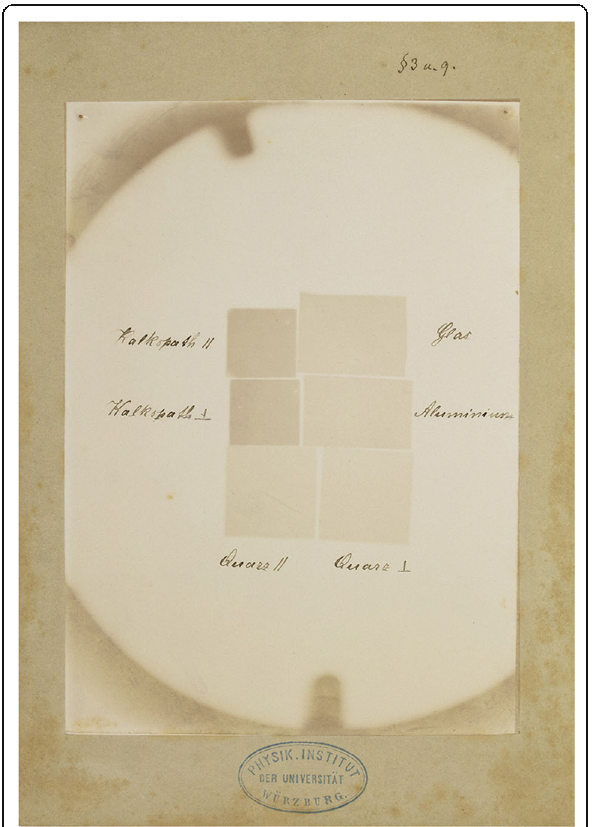
Fig. 9 A compass in a closed metal box. This image shows that, if the metal of the box is not too thick, the X-rays will pass and thus visualize the compass needle. Manually written legend: ‘ Magnetnadel in Metalldose ’ (compass needle inside a metal box). Paragraph referral: § 14